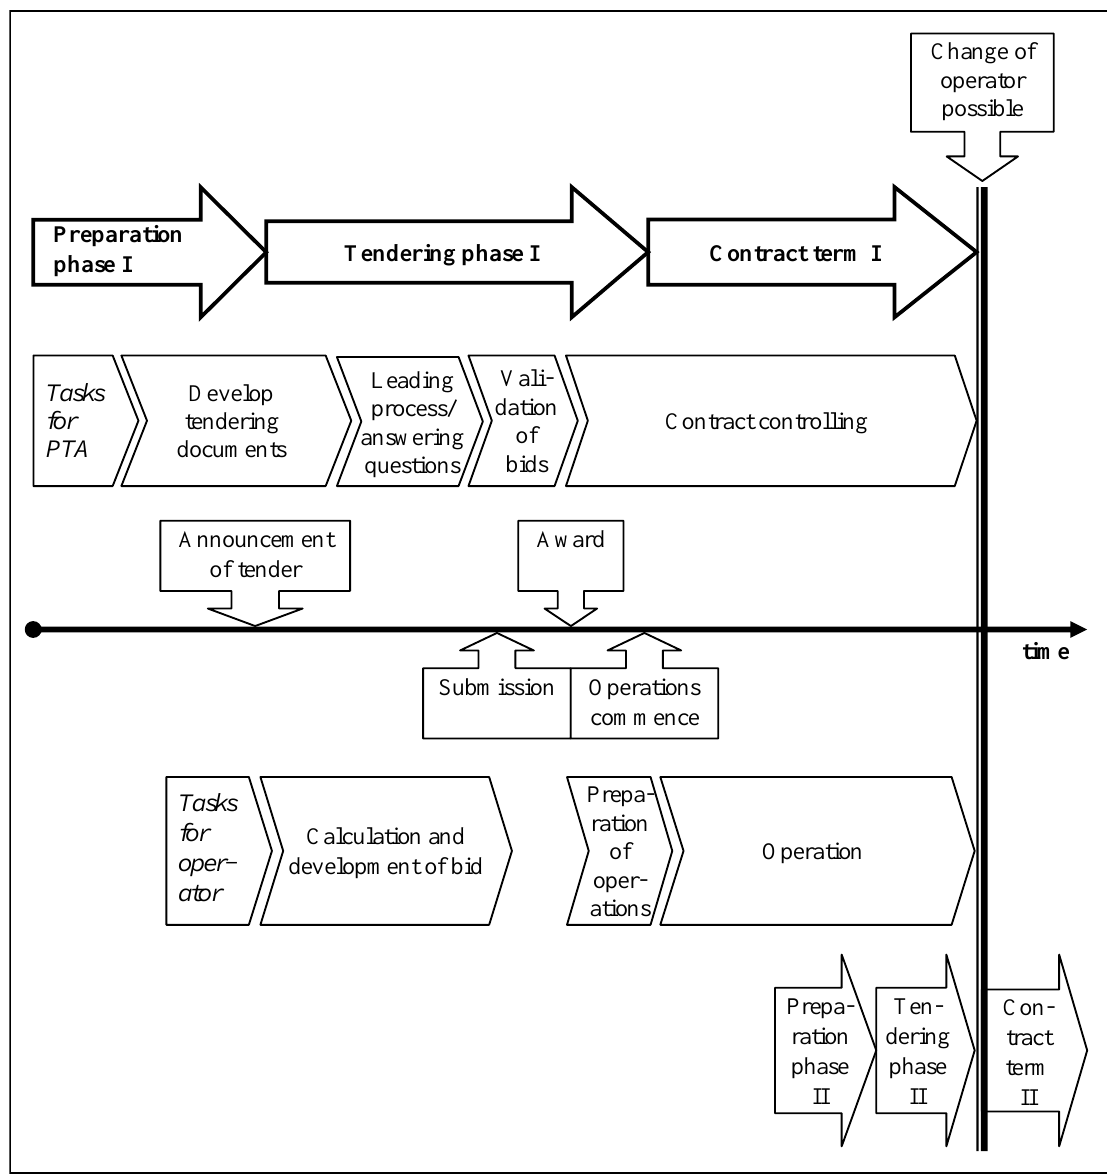
Figure 2. Schedule of tendering